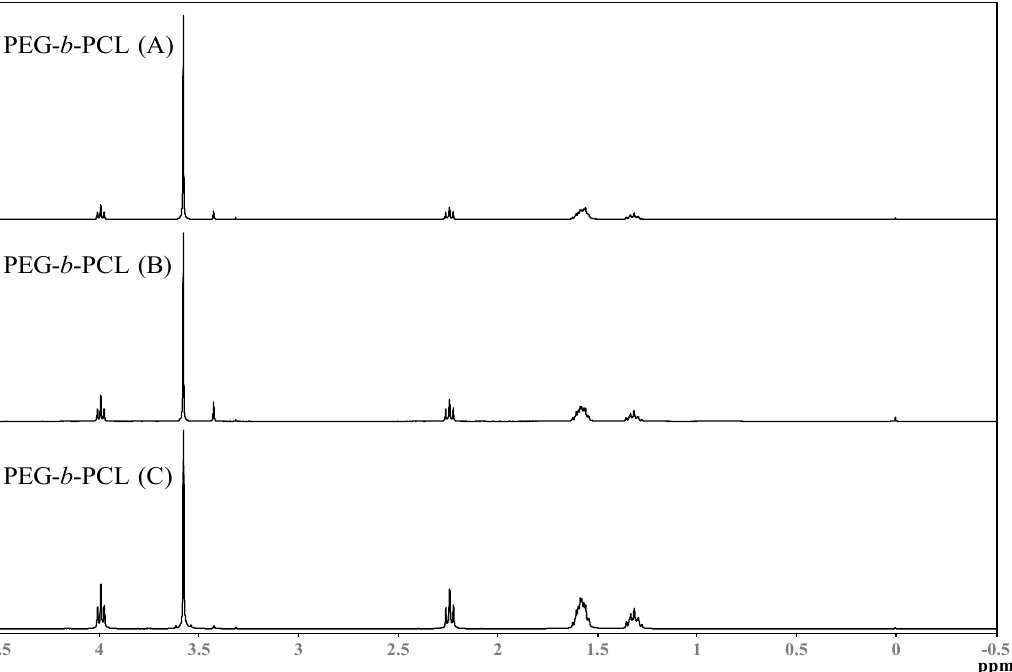
Figure 3. Fourier Transformed Infrared Spectroscopy (FTIR) spectra for Poly(ethylene glycol) (PEG) and the synthesized Poly(ethylene glycol)-b-poly( ε -caprolactone) copolymers.